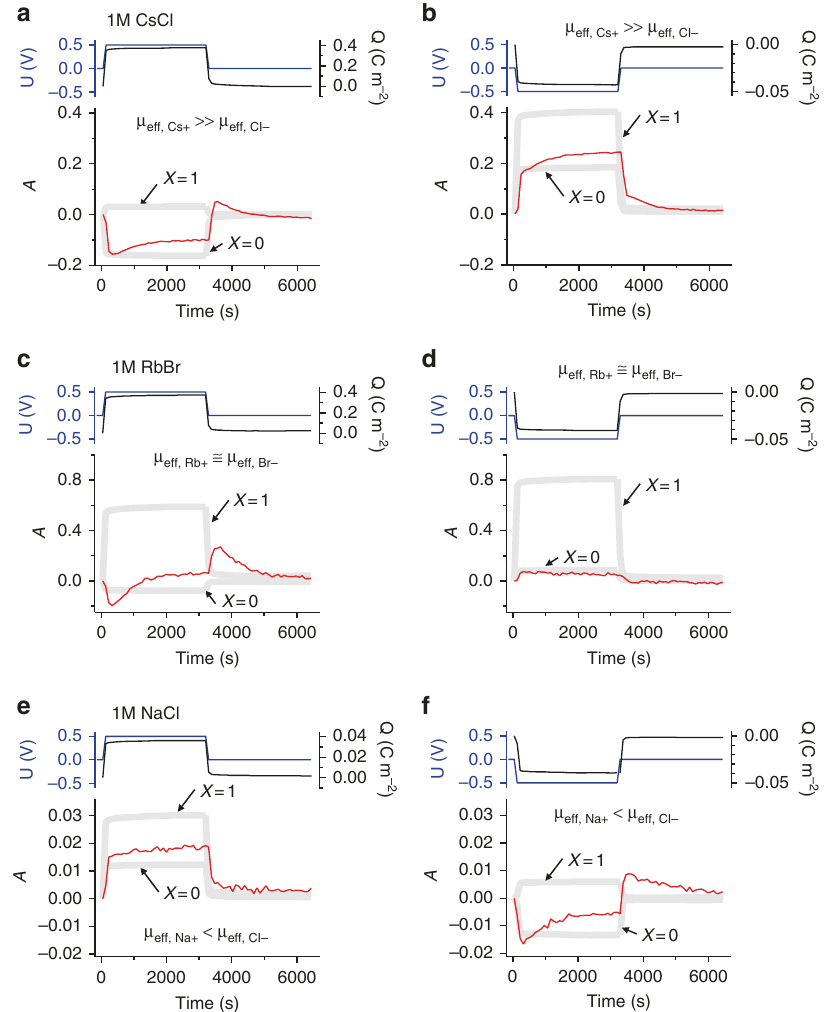
Fig. 3 Ion concentration change during potentiostatic charge/discharge. Cell voltage U (blue), charge signal Q (black), and relative attenuation A (red) versus time for 1 M CsCl, 1 M RbBr, and 1 M NaCl for a single chronoamperometry step at + 0.5 V ( a , c , e ) and -0.5 V ( b , d , f ). The thick gray lines indicate the theoretical attenuation curves calculated from Eq. 2 for pure ion swapping ( X = 0) and counter-ion adsorption ( X = 1). Note the different ratios between cation and anion attenuation coef fi cients μ eff of the different salts (Table